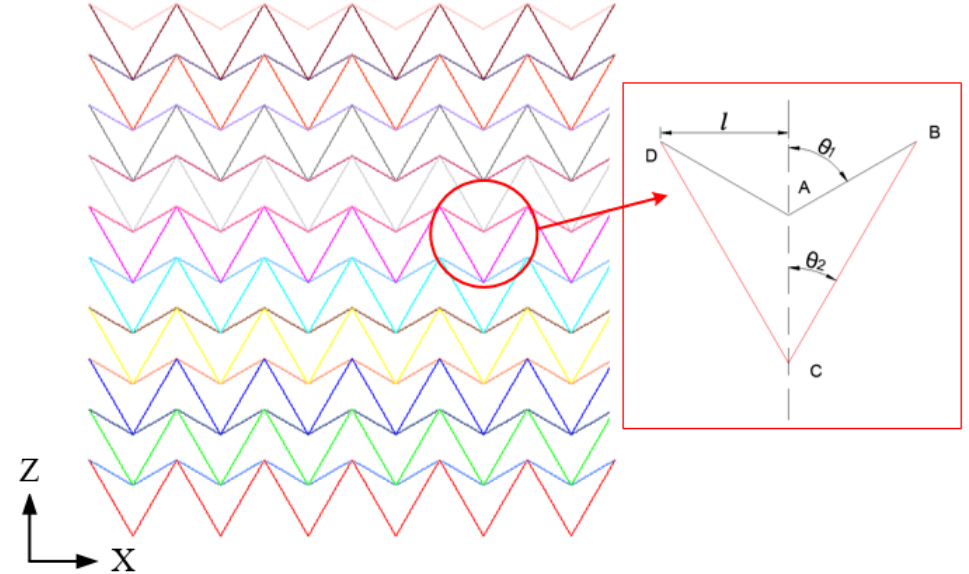
Figure 7. Schematic model of a 2D double-V NPR microstructure.